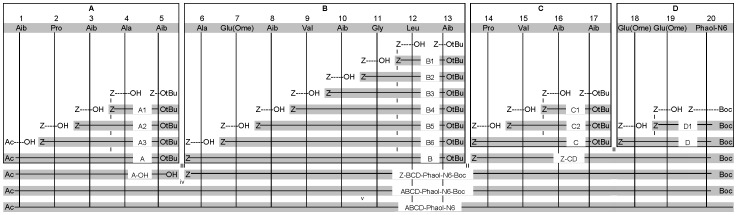
Synthetic strategy for the synthesis of ABCD-Phaol-N6 with Z = Cbz.(i) Cbz-removal with H2, Pd-C and MeOH followed by coupling via EDC/HOAt. (ii) OtBu-removal of the C-component with TFA/CH2Cl2 and Cbz-removal of the N-component with H2, Pd-C and MeOH, followed by coupling using EDC/HOAt. (iii) OtBu removal using ZnBr2 (iv) Cbz-removal of the N-component with H2, Pd-C and MeOH, followed by coupling via HOAt/EDC (v) Boc-deprotection using BiCl3.